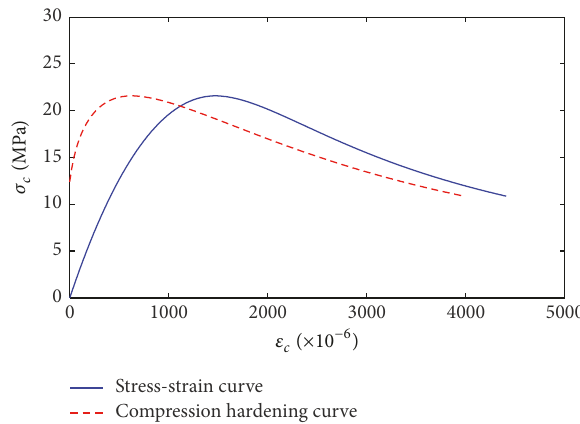
Figure 5: Total stress-strain relation under uniaxial compression and compression hardening curve of mortar.